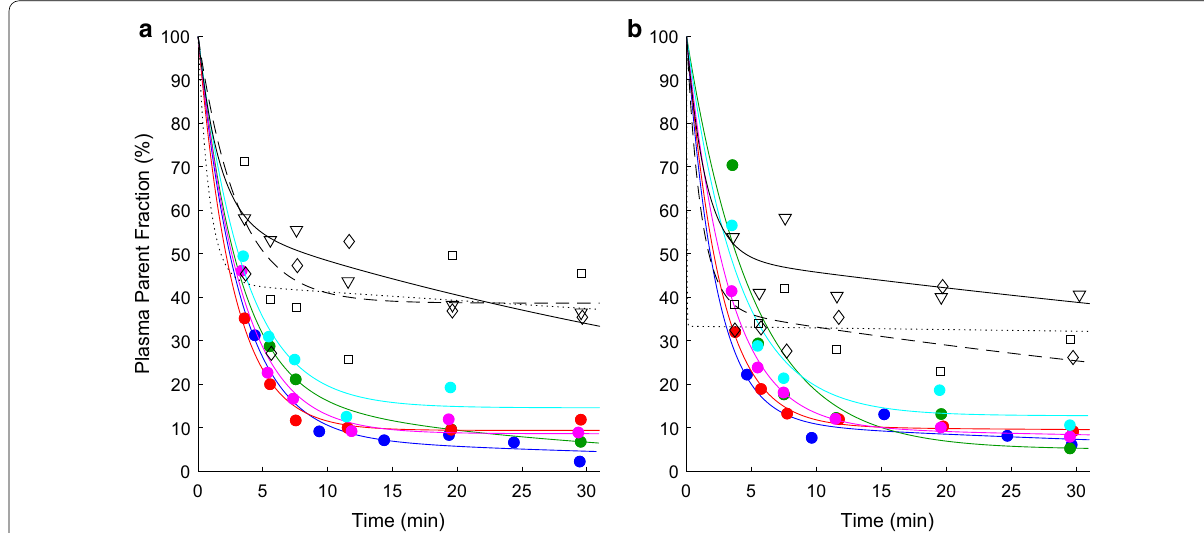
Fig. 1 Plasma parent fraction data and fit. Plasma parent fraction for a test scan and b retest scan for each subject. Symbols represent ratio of parent compound, [ 13 N]ammonia, to total 13 N labelled fractions (parent plus metabolites) measured from individual arterial plasma samples. Lines show biexponential fits to subject/scan data sets. Coloured lines and circles show colour-coded subjects 1–5 used in the full analysis (blue, green, red, magenta and cyan, for subjects 1–5, respectively). Black symbols and lines (triangle/solid, square/dashed, diamond/dotted for subjects 6–8, respectively) show subjects 6–8 considered corrupted data. X -axis is time in minutes from injection (corrected for brain-detector delay). Y -axis